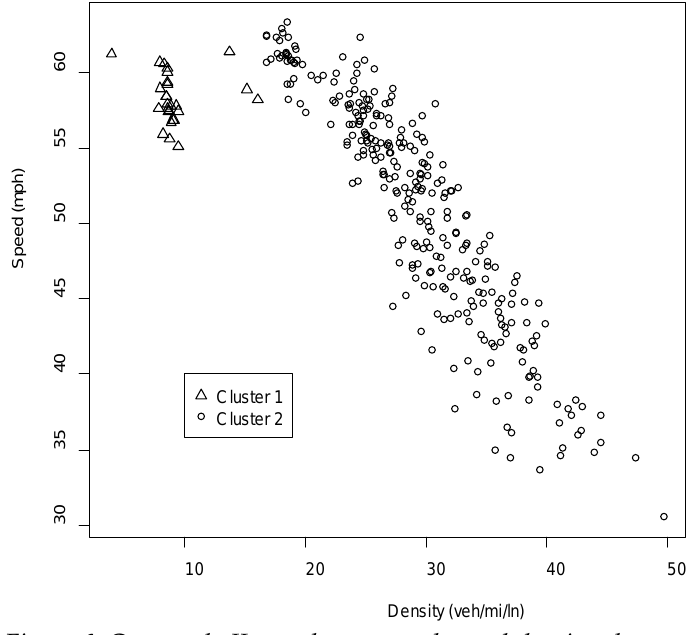
Figure 6. Case study II two clusters truck speed-density plot Table 7. Case study II cluster centers of two clusters analysis